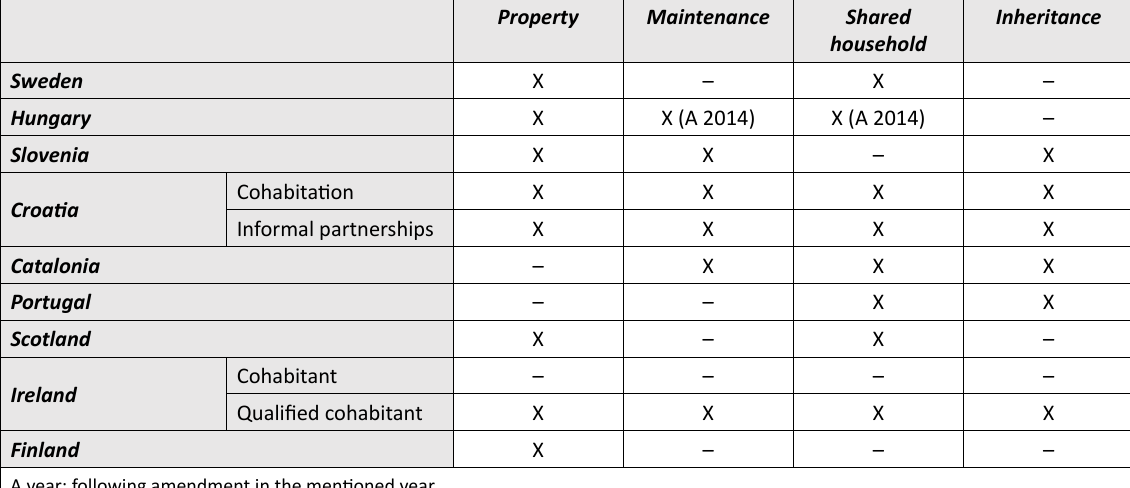
General overview of areas in which legal effects of informal relationships are regulated in nine European